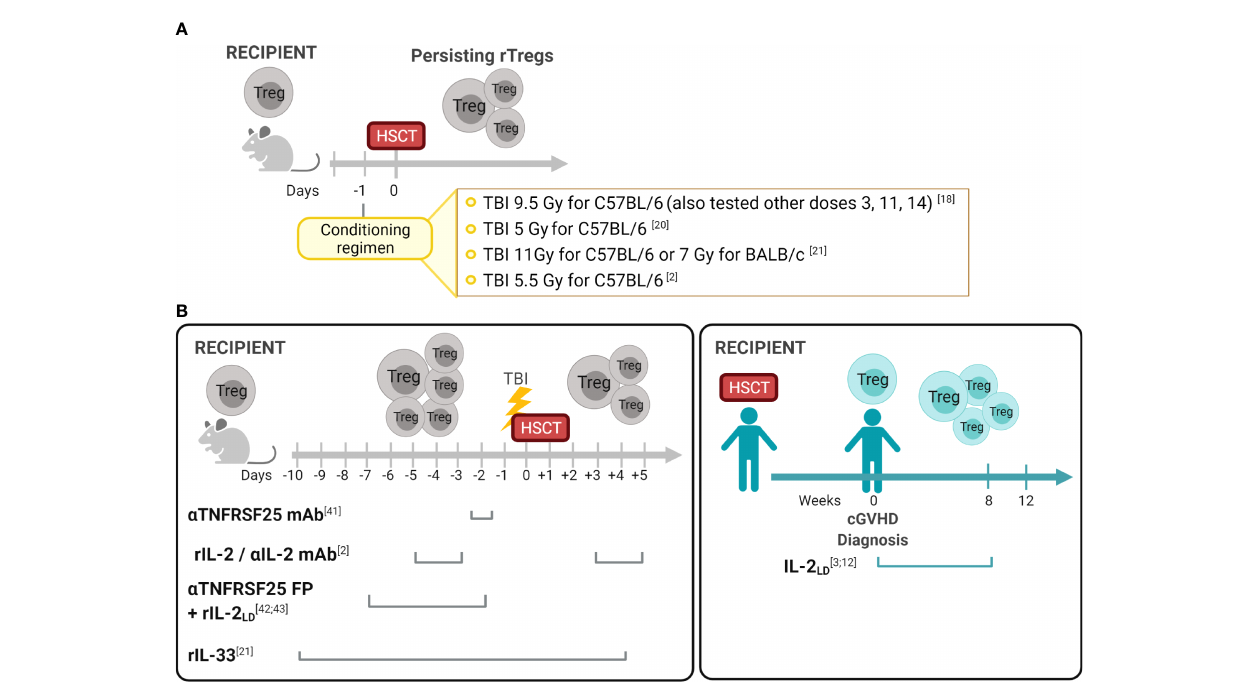
FIGURE 1 | Recipient Treg persistence and manipulation in allogeneic hematopoietic stem cell transplantation (A) Persisting Tregs (rTregs) have been identi fi ed after different conditioning protocols in recipients post-autologous or T cell depleted allo-HSCT (18). These fi ndings established the opportunity to consider manipulating this population before and/or after transplants to diminish GVHD and improve overall outcomes. (B) Manipulation of the Treg compartment in experimental and clinical HSCT. In contrast to the post-transplant period when both rTreg and dTreg populations could be present in recipients ( Table 1 ), in the pre-transplant period only rTregs can be regulated. Reagents which engage receptors on Tregs were utilized in vivo to activate these cells and diminish GVHD. As noted, some treatments were administered only in the pre-transplant period (anti-TNFRSF25mAb +/- rIL-2; IL-2/ a IL-2mAb) and another pre and early post-HSCT (IL-33). Notably, studies in clinical HSCT recipients administered the reagent (rIL-2) only following transplant and GVHD diagnosis. Created with